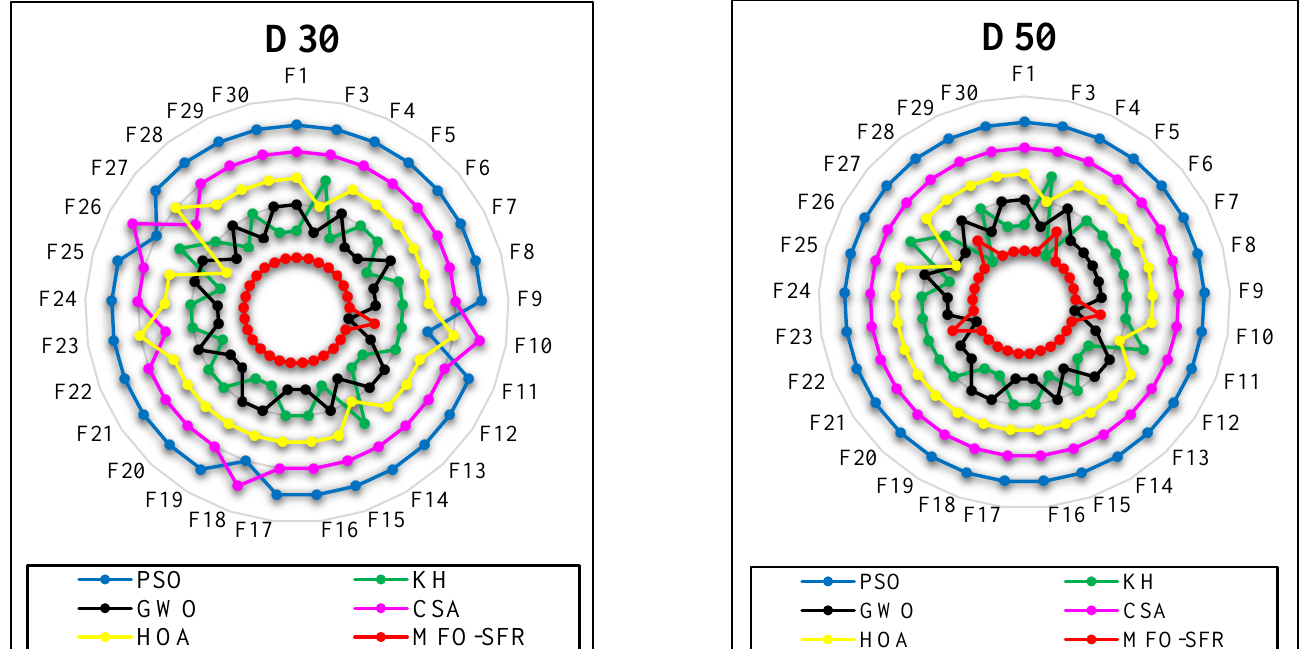
Figure 3. Exploratory data analysis of MFO-SFR and other well-known MFO algorithms on CEC 2018 with 30 and 50 dimensions.